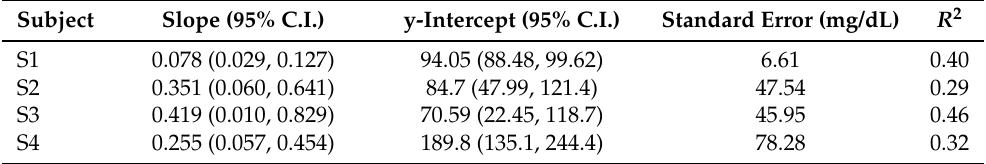
Figure 10. Clarke error grid analysis (EGA) of the glucose predictions for a non-diabetic subject S1, pre-diabetic subject S2, type I diabetic subject S3, and type II diabetic subject S4 (black dots: Day 8 samples, red dots: Day 9 samples, orange line: linear least-squares regression of the reference versus the predicted glucose concentrations). Table 6. The regressed coefficients (slope and y-intercept), standard error (SE), and coefficient of determination ( R 2